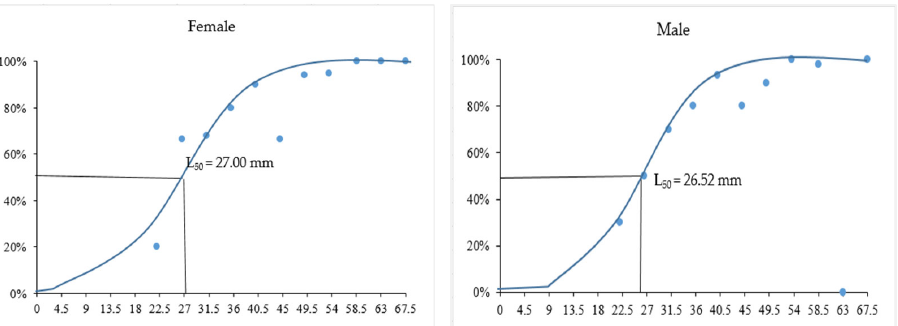
Figure 8. Percentage of mature individuals and the total shell length (SL) for females and males of Pinctada capensis from Inhaca Island.